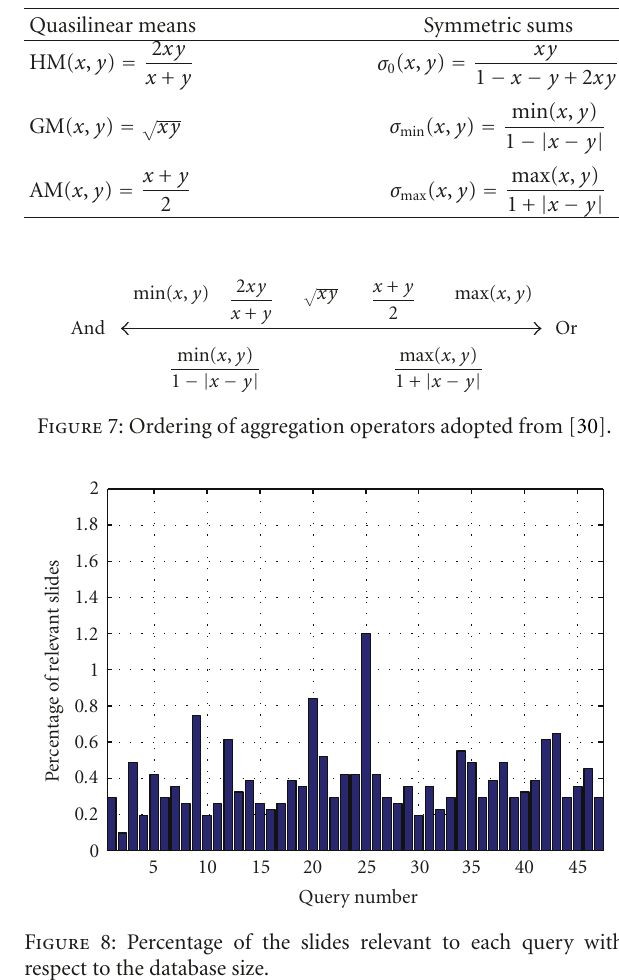
Table 1: Example of quasilinear means and symmetric sums. HM: harmonic mean, GM: geometric mean, AM: arithmetic mean.